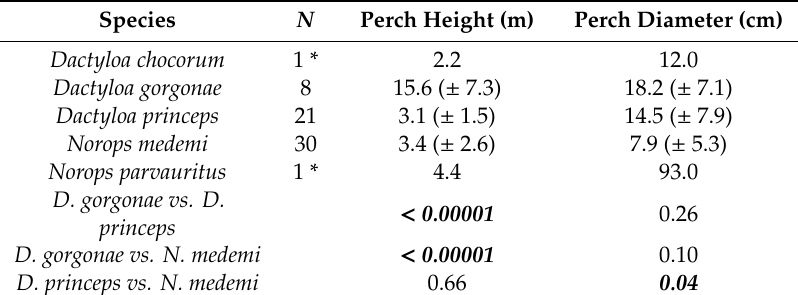
Table 5. Mean values and pairwise comparisons of habitat use in Isla Gorgona anoles. Bold values are statistically significant. * Denotes that only one individual was observed and is not believed to reflect typical habitat use.